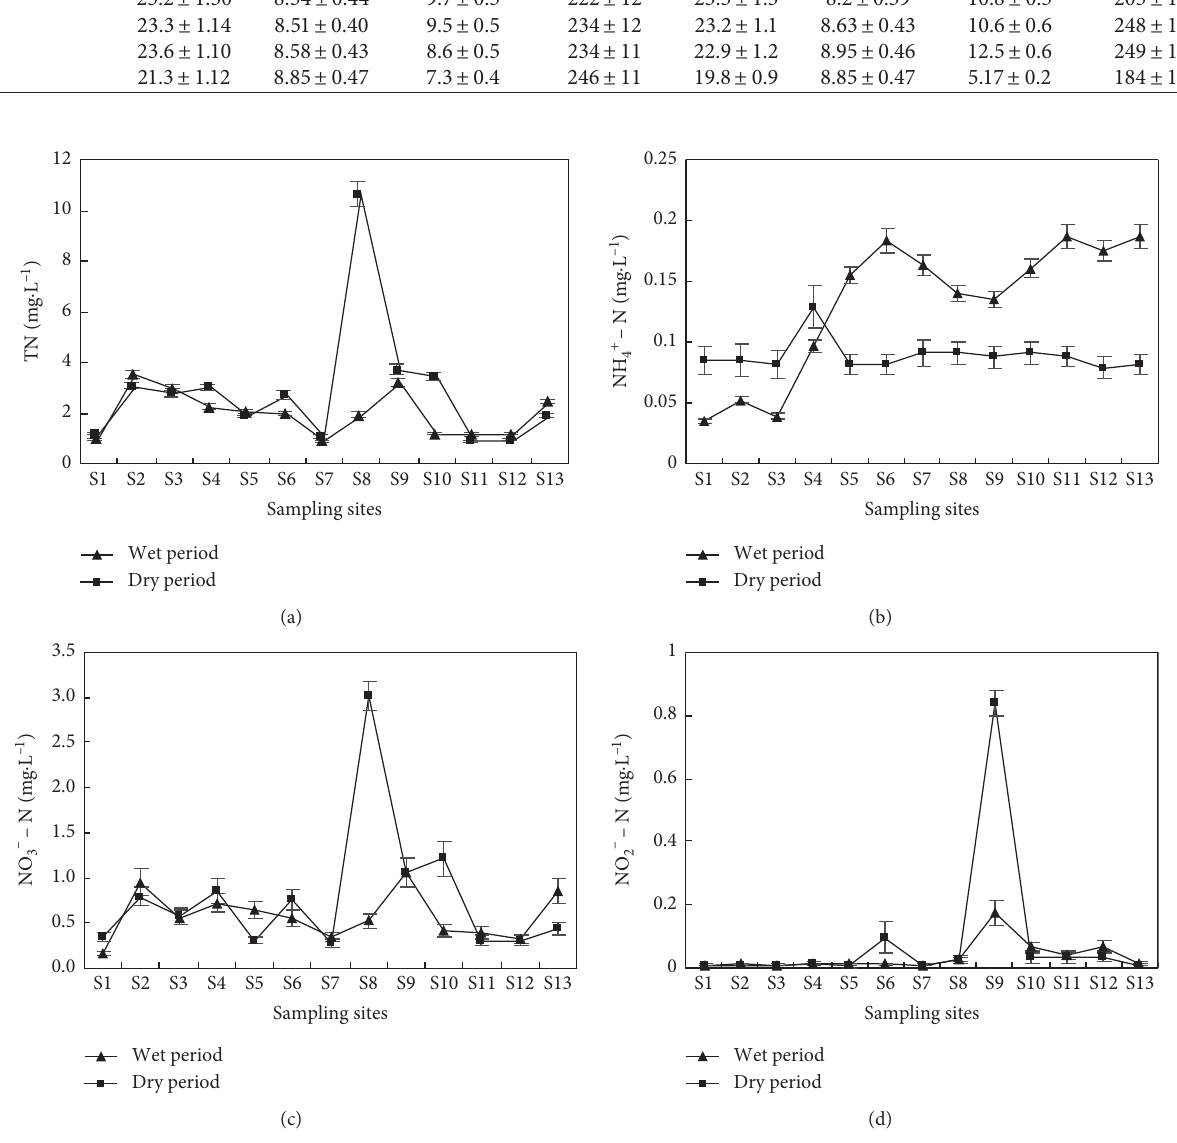
Figure 2: Distribution characteristics of different forms of inorganic nitrogen in study